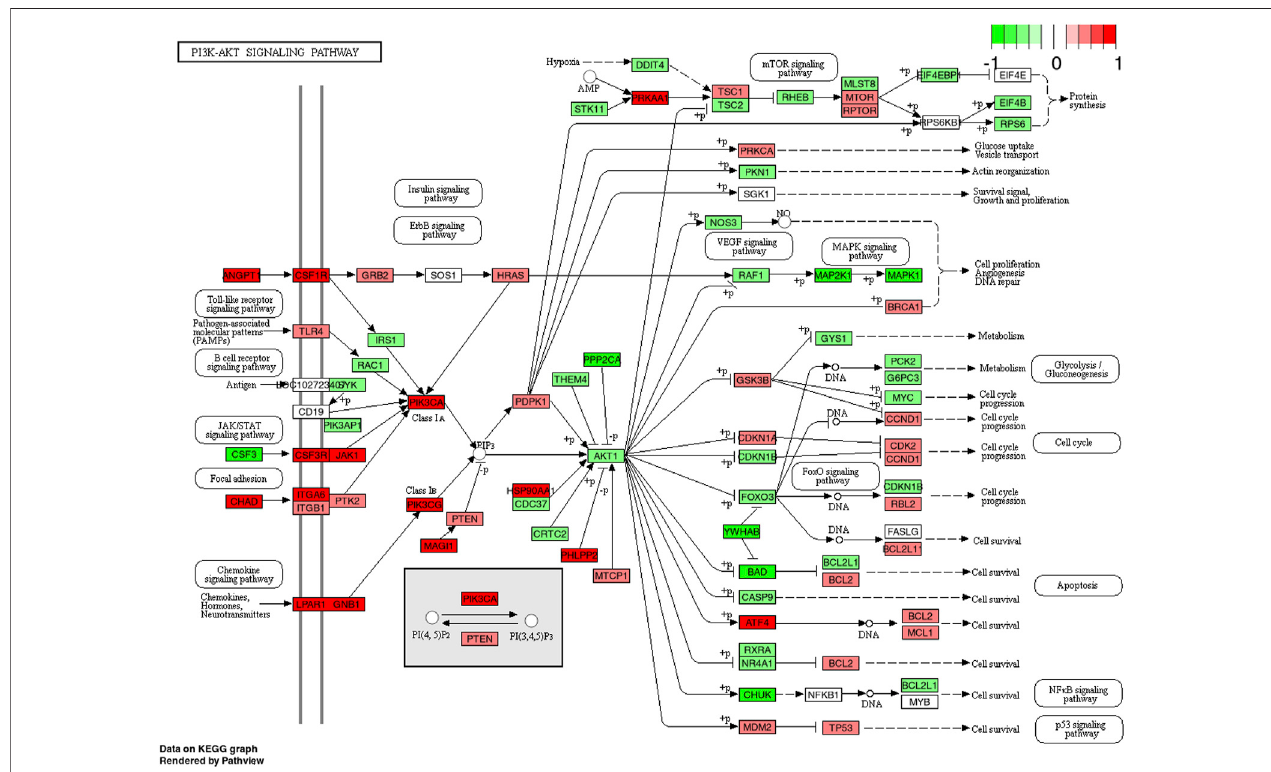
FIGURE 4 | KEGG pathway of the PI3K-Akt signaling pathway with individual genes at 4 h comparing CP (collagen peptides) and PLA (placebo). Color label indicates genes that are up (red) or down (green) regulated compared to PLA. Dark coloring = p -value equal or below 0.05, light coloring = p -value higher than 0.05.